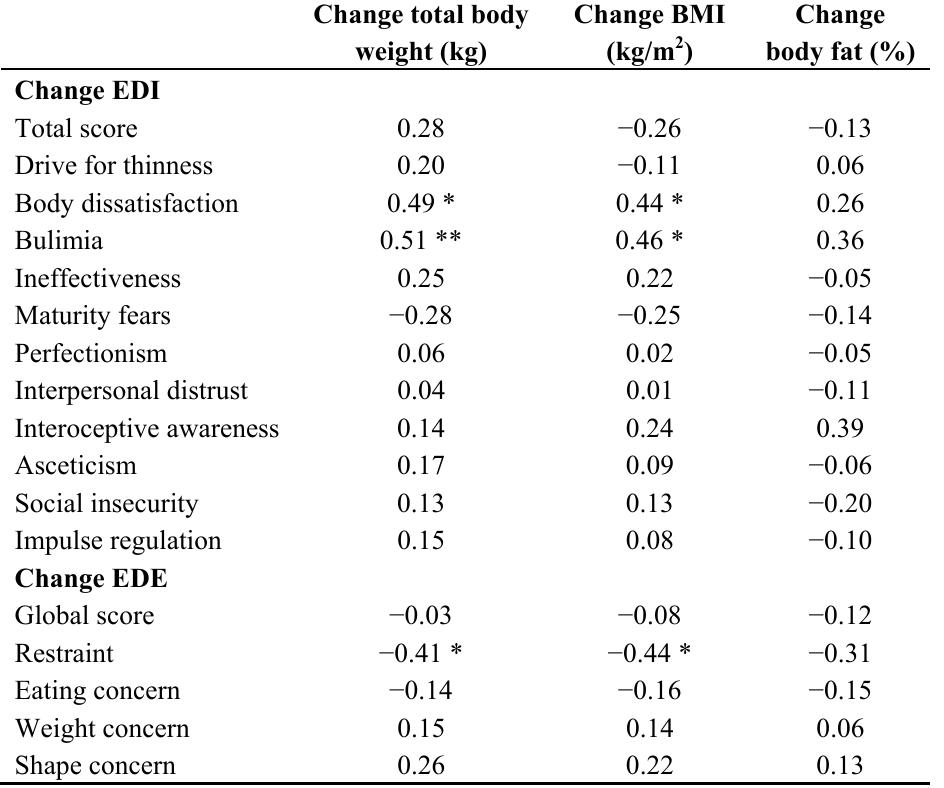
Table 4. Correlations between changes in body composition and ED